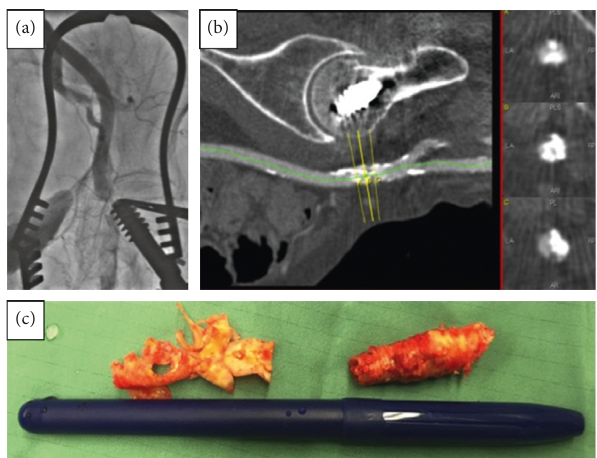
Figure 3: (a) Control angiography showing complete occlusion of the left femoral artery just distal to the puncture site. (b) MSCTof the left femoral artery showing heavy calcification at the level of the femoral head. Red arrow shows puncture site. (c) Calcific atheroma from the left common femoral artery during the femoral endarterectomy.